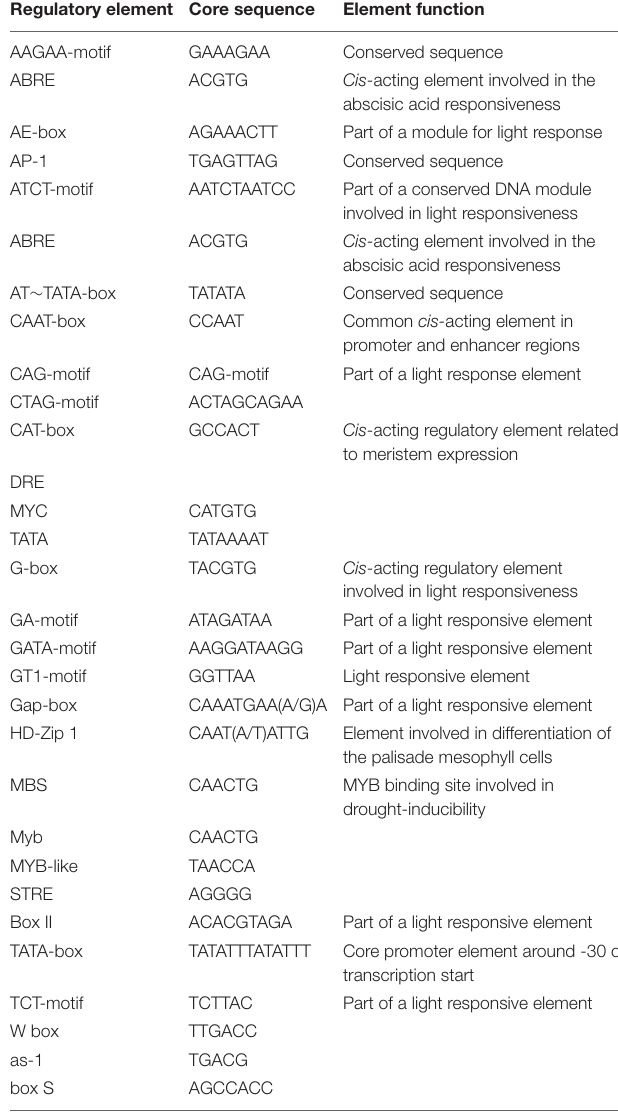
TABLE 2 | Annotation of cis -acting elements at the 5 (cid:48) end of P450